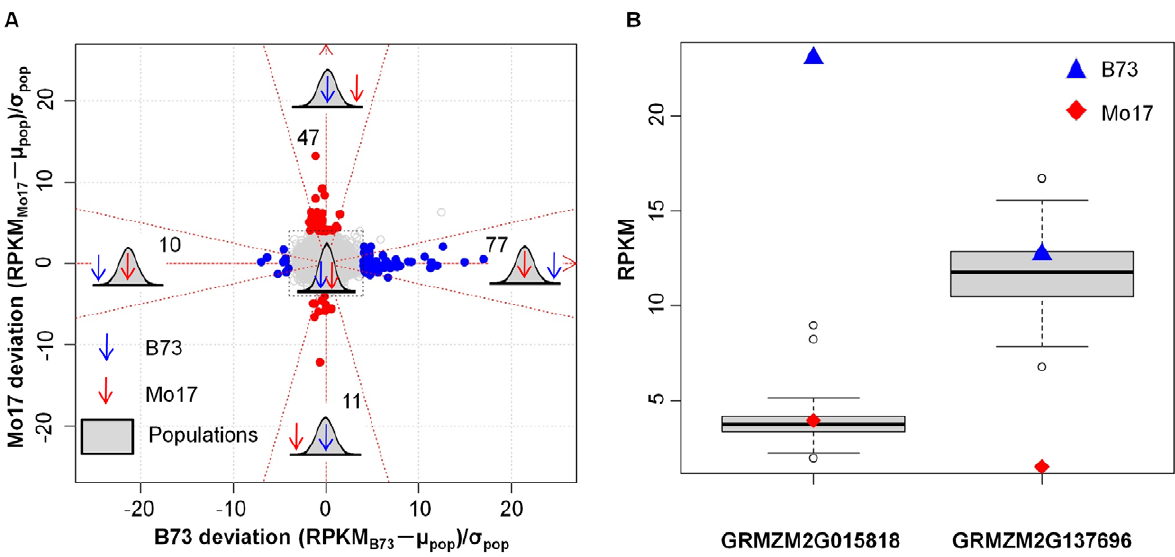
Figure 2. Paramutation-like expression patterns in the IBM RILs. (A) Two-dimensional representation of expression level variation among B73, Mo17 and the IBM RILs. The plot illustrates the expression level of B73 and Mo17 relative to the population mean and standard deviation for all 28,603 genes. The x-axis represents the number of standard deviations of difference between B73 and the RIL population while the y-axis represents the number of standard deviations between Mo17 and the population mean. Each point represents the expression relationship between the two parents and the RILs for one gene. The blue and red circles indicate genes with paramutation-like expression patterns in which B73 is at least three standard deviations outside the range of the RILs (blue) or Mo17 is at least three standard deviations outside the range of the RILs (red). The density plots provide a visual representation of each type of pattern that was identified. To provide better resolution for those genes with paramutation-like expression patterns, four genes, of which the parental expression levels were extremely out of the range of the expression levels in the RILs, were not plotted, but listed in Table S2. (B) The distribution of expression levels is shown for two genes with paramutation-like expression patterns. The y-axis shows the RPKM value for the normalized expression levels.